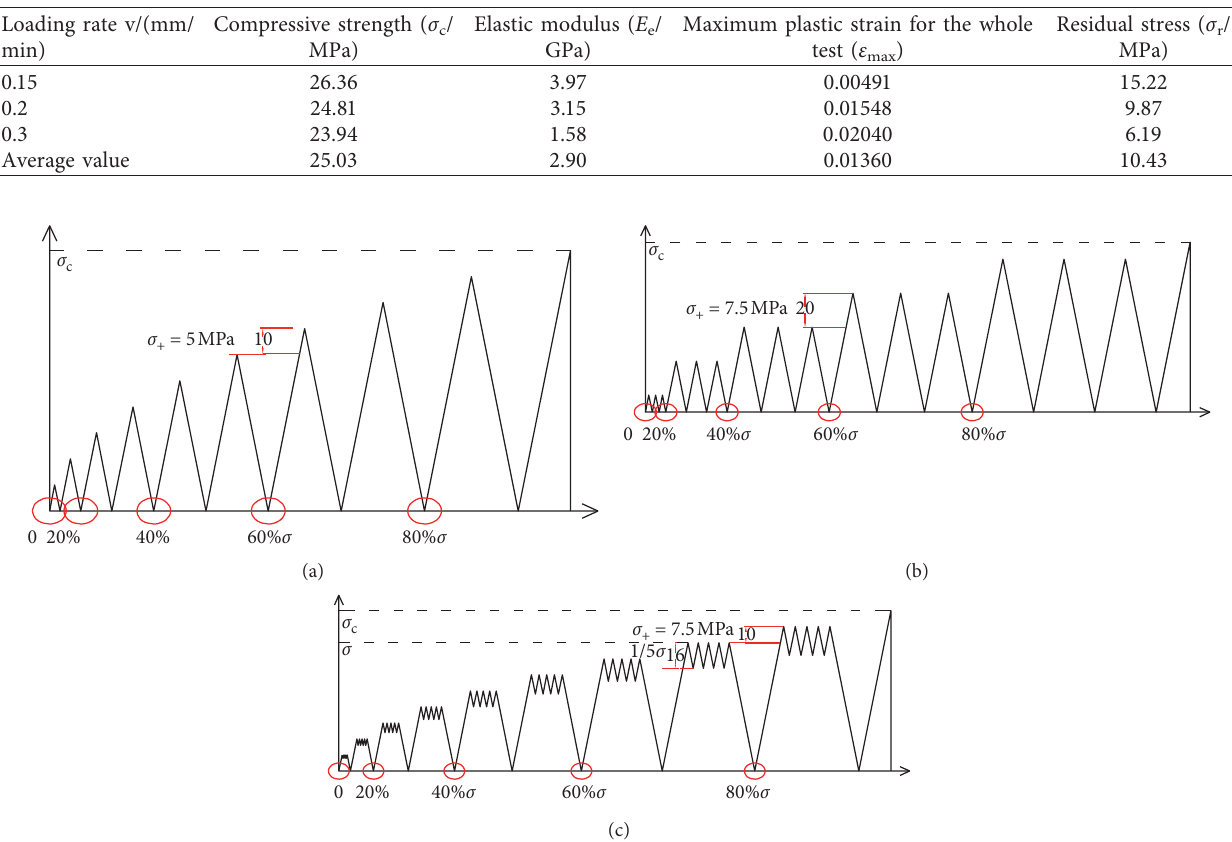
Table 3: Basic parameters of rock samples.